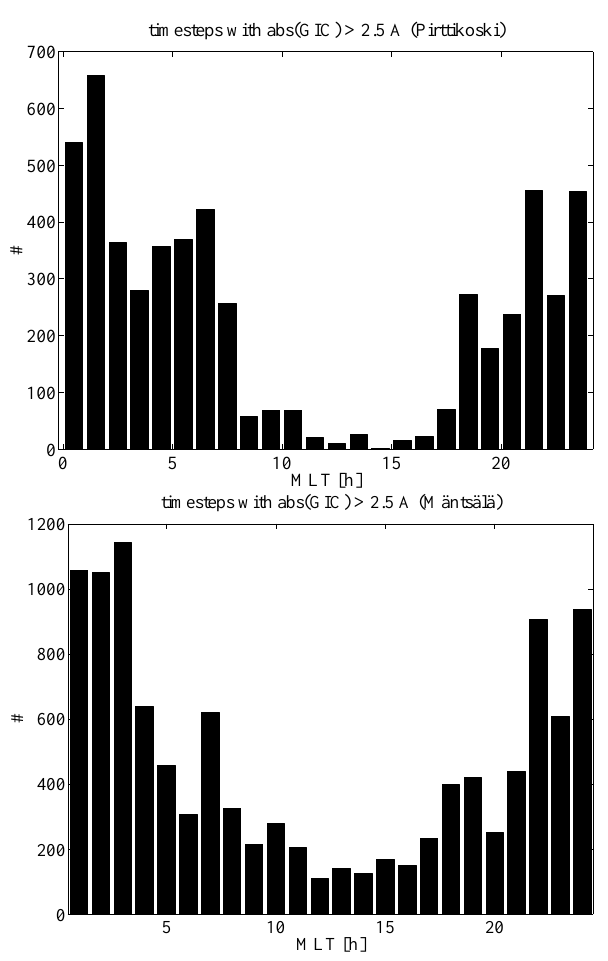
Fig. 11. Diurnal variation of the number of timesteps from 1999 to 2000 when the absolute value of GIC exceeded 2.5 A at the Pirttikoski 400kV transformer, and in the natural gas pipeline in M¨ants¨al¨a (10 s data). Compare to Fig.